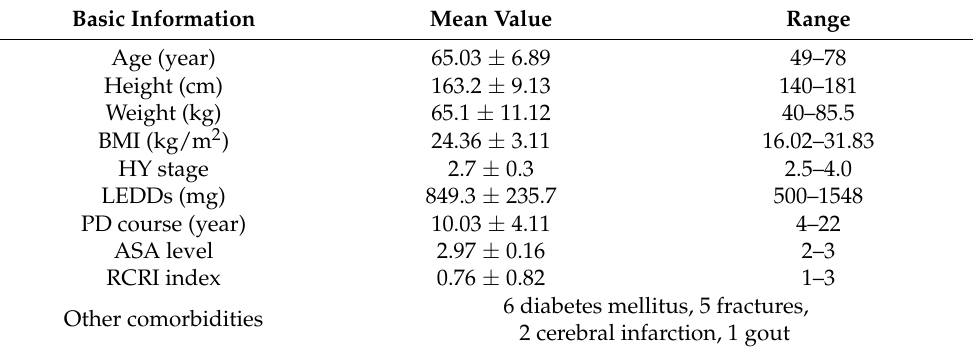
Table 1. Population characteristics.